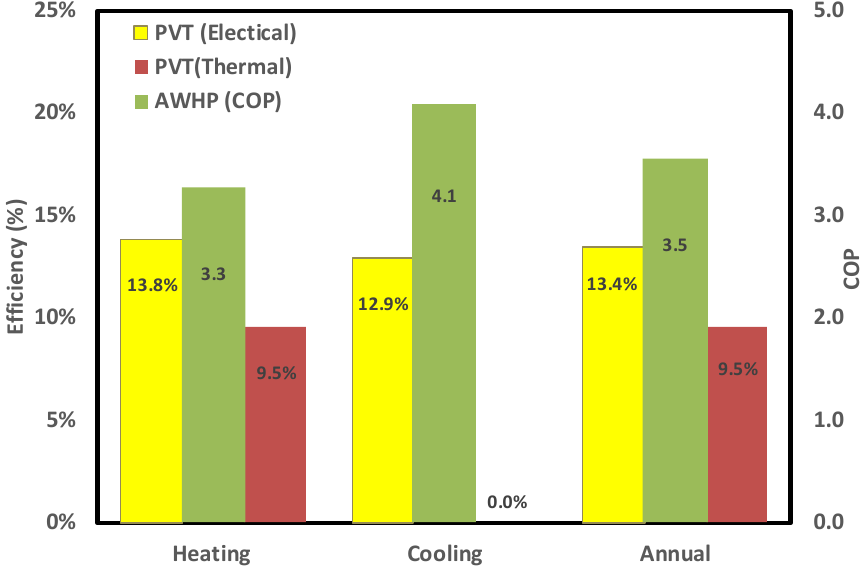
Figure 9. Hybrid Trigeneration system